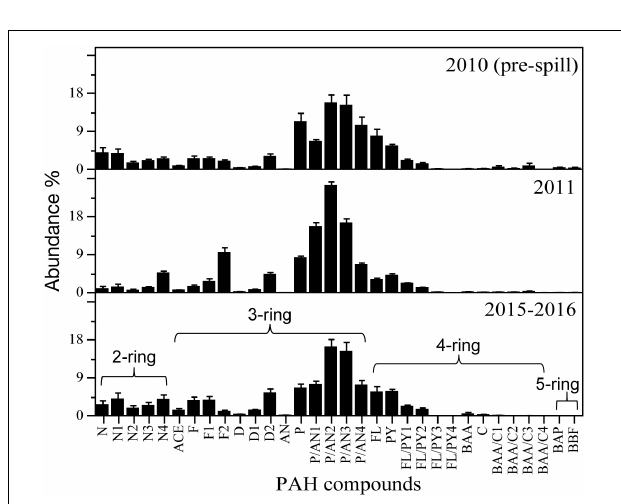
FIGURE 6 | Relative abundance (%) of PAH compounds in the mantle tissue of deep-sea cephalopods collected in the northern Gulf of Mexico. Sampling years: pre-spill: 2010, post-spill: 2011, and long-term: 2015–2016. Data are shown as mean ± SE.